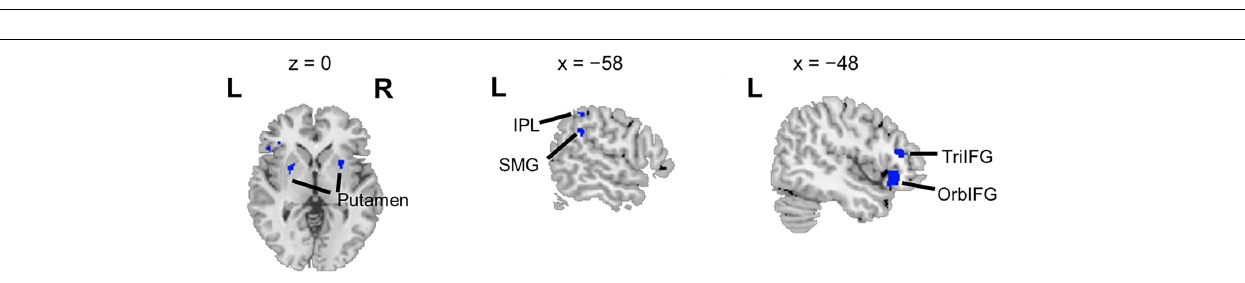
p < 0.001, uncorrected (clusters activated by the main effect of priming type are in both warm and cold colors in Figure 3A